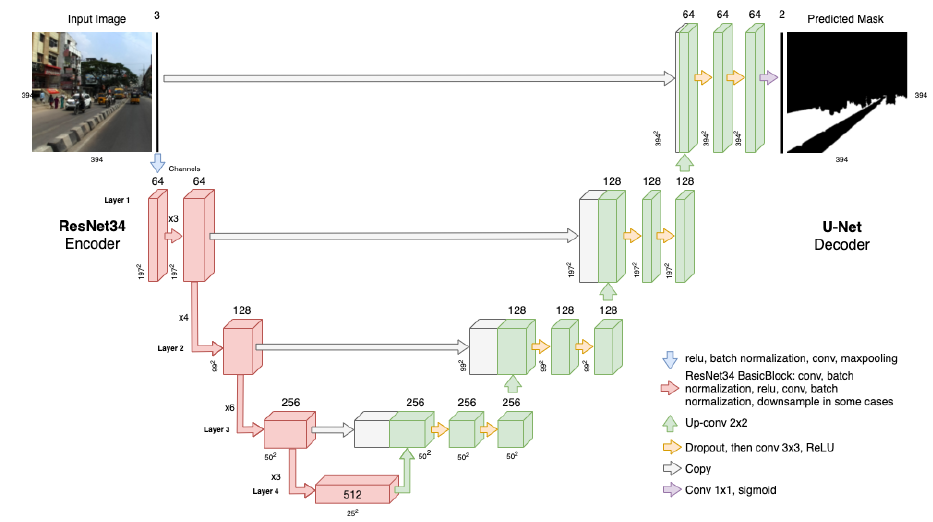
Figure 4. Resnet34+UNet: final architecture implemented with PyTorch for road segmentation. To optimise the model, we used the BCEWithLogitsLoss function provided by PyTorch to achieve greater numerical stability. This loss function extends the binary cross entropy loss function by applying additional sigmoid activations f to the output vectors coming from the decoder . In general, binary cross entropy has the purpose of quantifying the probability that each data point belongs to each class in a binary classification task. A mathematical representation of BCEWithLogitsLoss is shown in Equation (1), where y i and ˆ y i represent a ground truth binary classification vector and a predicted binary classification vector, respectively. Moreover, T is the number of data points, and the sigmoid activation function f is shown in Equation